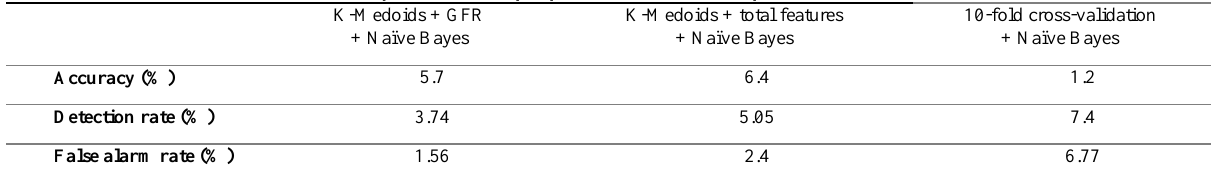
Table 7. Improvement of proposed method in comparison with others. K-Medoids + GFR + Naïve